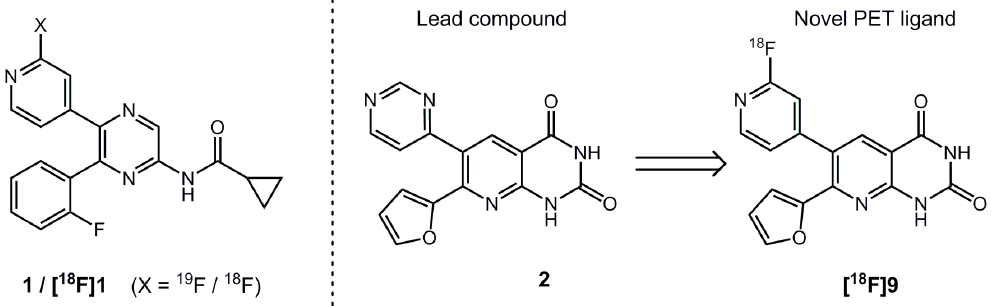
Figure 1. Molecular structures of the previously radiofluorinated PET ligand [ 18 F]1 [14], the selected new bicyclic lead compound 2 [16], and the newly developed A 2B receptor PET ligand [ 18 F]9 .